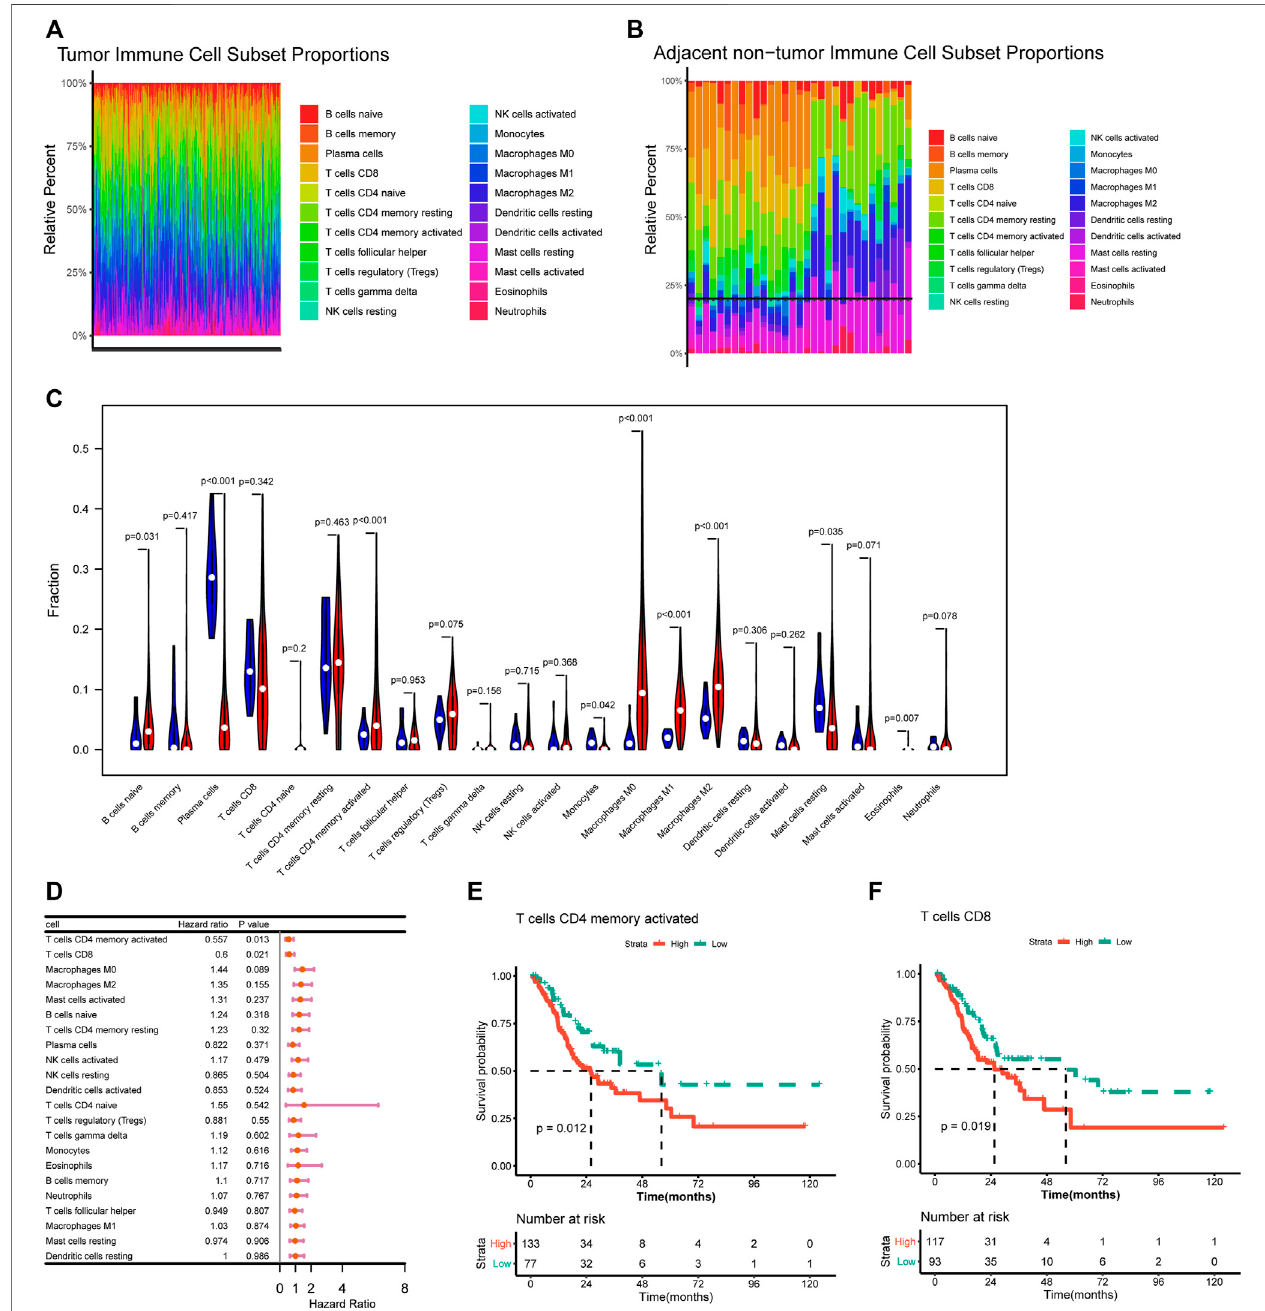
FIGURE1| Correlationofimmunein fi ltrationandoverallsurvival. (A – B) Histogramshowedthedistributionof22immunecellsintumortissue (A) andnormaltissue (B) . (C) Violin plot showed the differences on 22 immune cells in fi ltration in normal and tumor tissue. (D) Forest plot showed the correlation of immune in fi ltration and overall survival. (E – F) Kaplan-Meier survival curves showed the correlation of immune cells in fi ltration and overall